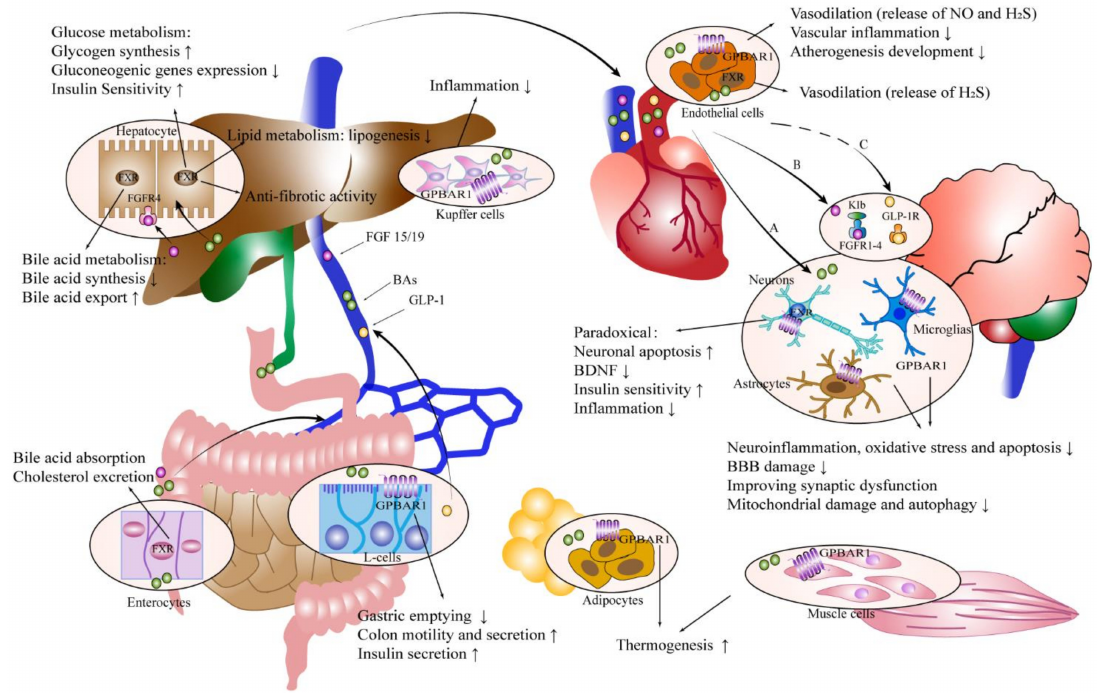
Figure 3. Potential molecular targets of single and dual GPBAR1/FXR agonists in NAFLD and brain illnesses include FXR and GPBAR1. BAs in the liver trigger the activation of FXR,